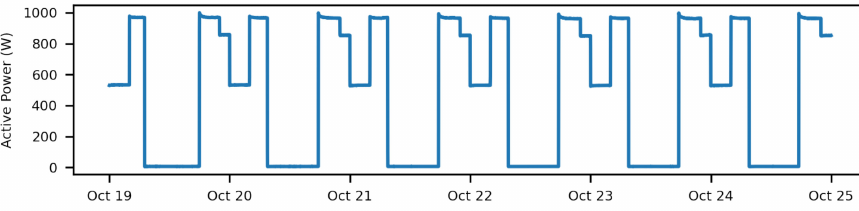
Figure 4. Graph of the active power of one phase for lamps with